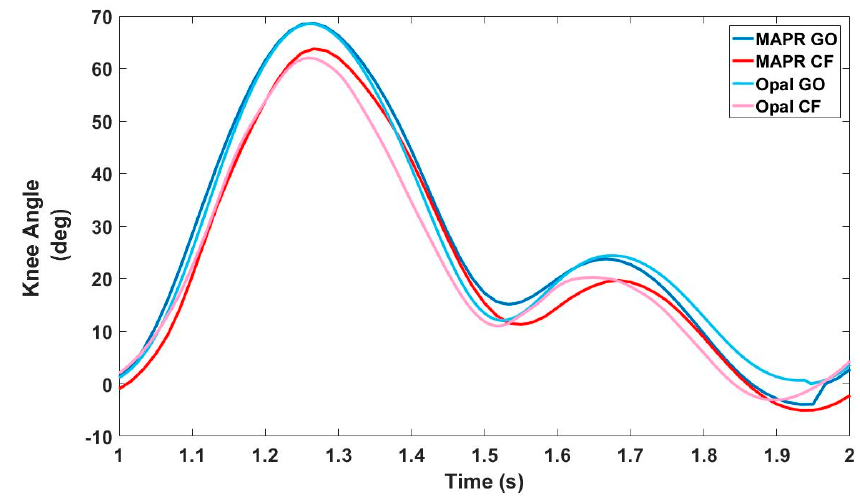
Figure 11. Representative knee angle waveform under each condition. GO and CF performance were distinct from each other. GO consistently overestimated knee angle compared to CF.